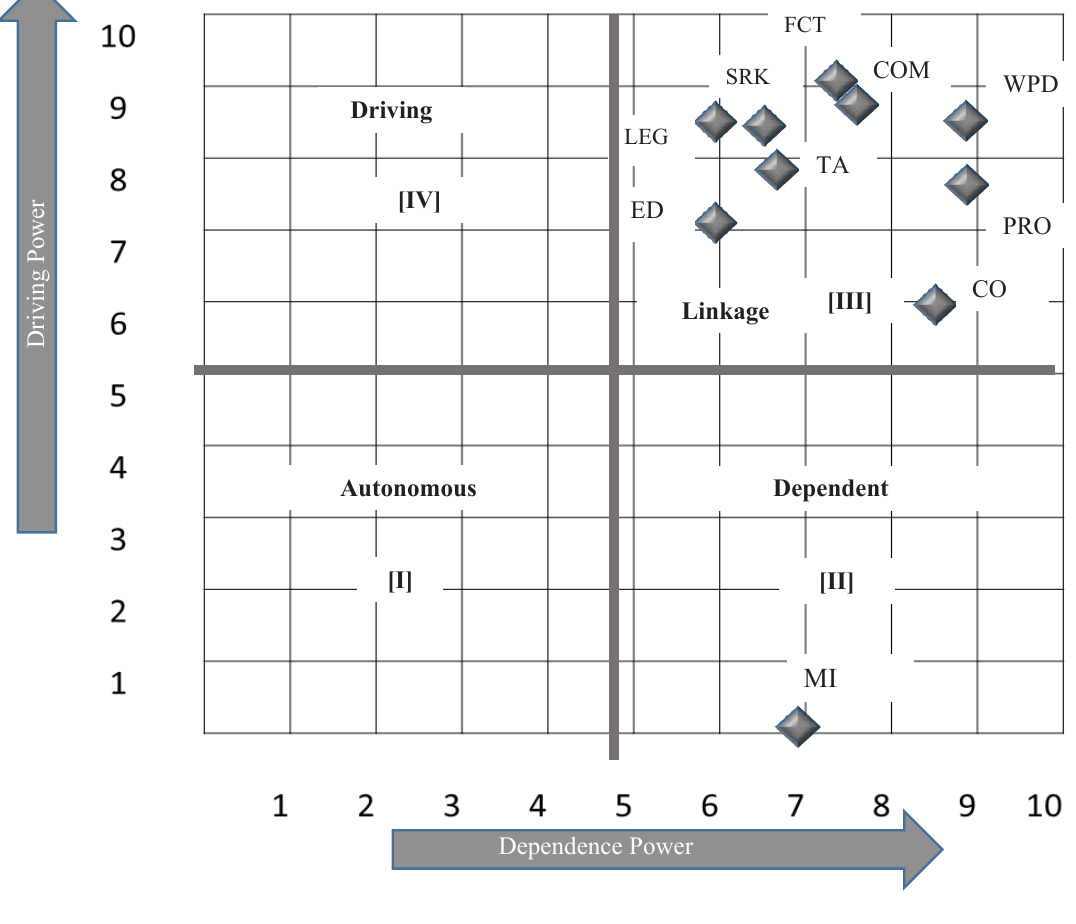
Figure 2. Classification of barrier variables using Fuzzy MICMAC